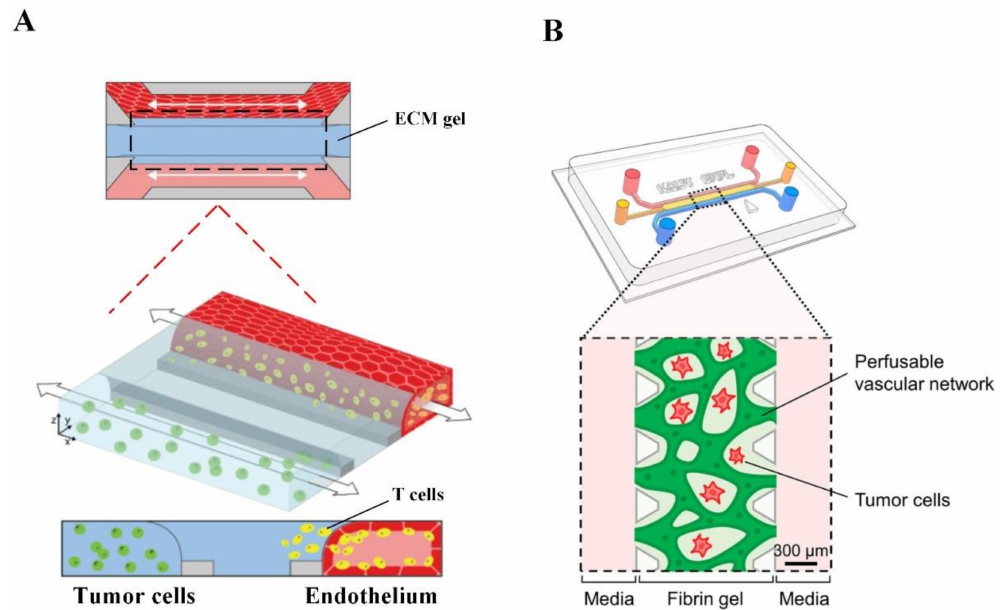
Figure 3. Microfluidic tumor-microvascular model. ( A ) OrganoPlate tumor microvascular mod- els with high throughput screening capabilities. Adapted with permission from [55] © Creative Commons Attribution License (2021). ( B ) A microfluidic chip with functional, cross-linked tumor microvascular networks. Adapted with permission from [57] © ACS Publications